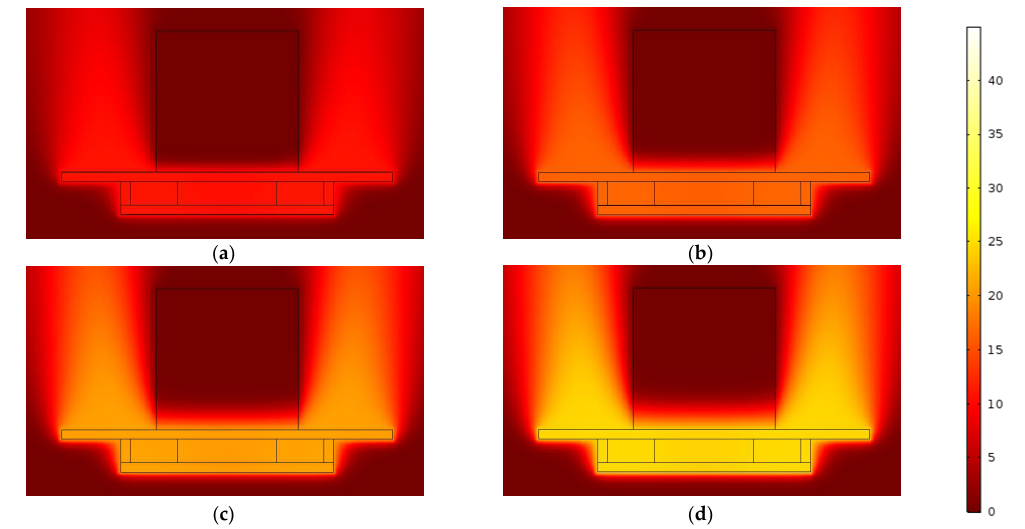
Figure 11. Temperature distribution (°C) around IH device (40 kHz, 2 A, 50 turns) for an initial temperature of 0 °C after 2 min ( a ), 4 min ( b ), 6 min ( c ), 8 min ( d ).